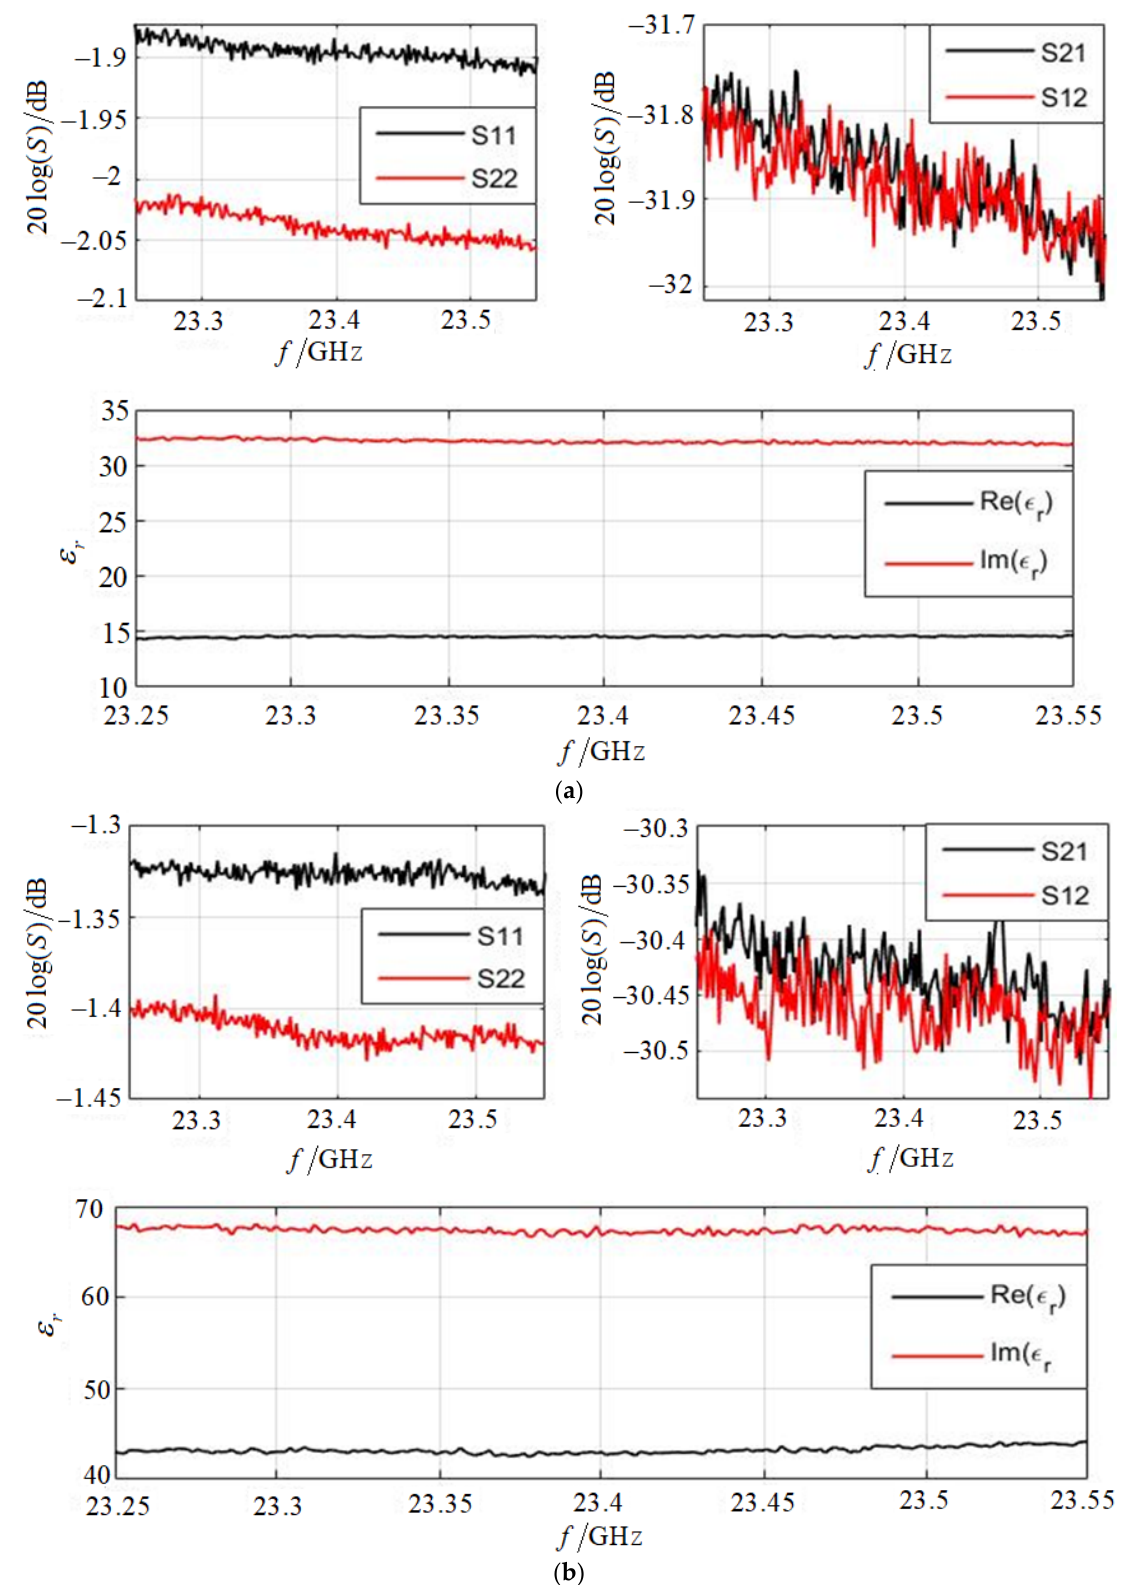
Figure 8. The measured scattering parameters and inversed permittivity. ( a ) Carbon black volume ratio is 25%; ( b ) carbon black volume ratio is 30%.